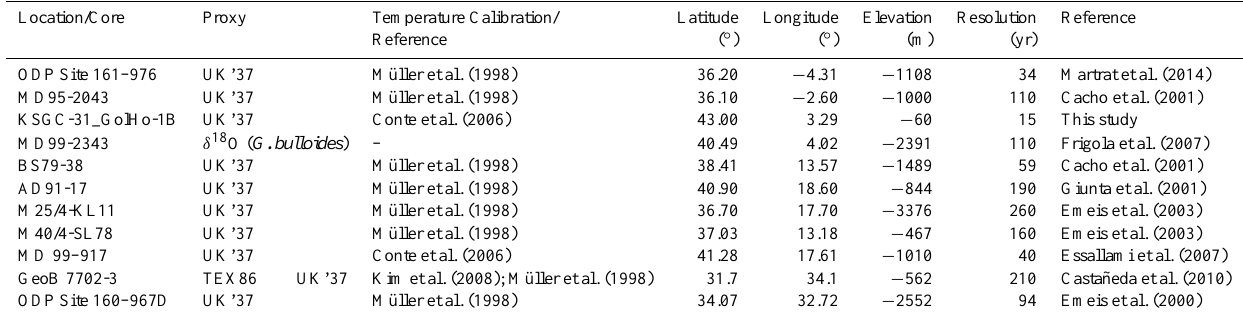
Table 4. List of data sets used in Fig.